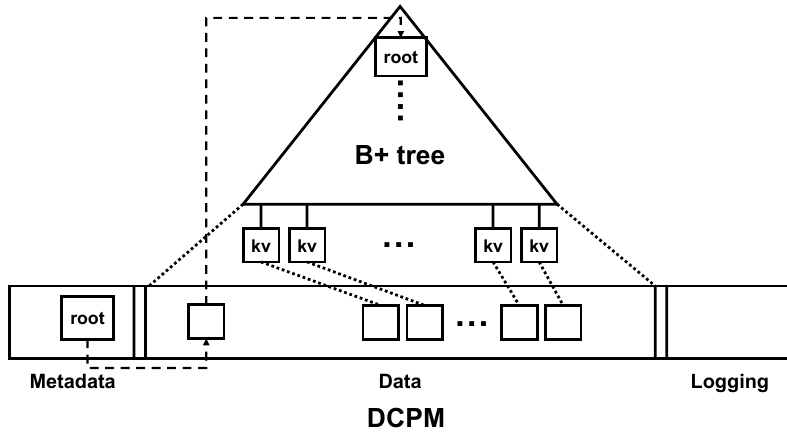
Figure 2. The address space of DCPM partitioned for